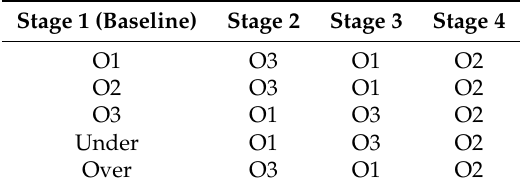
Table 3. Stage order is determined by the user’s behavior during Stage